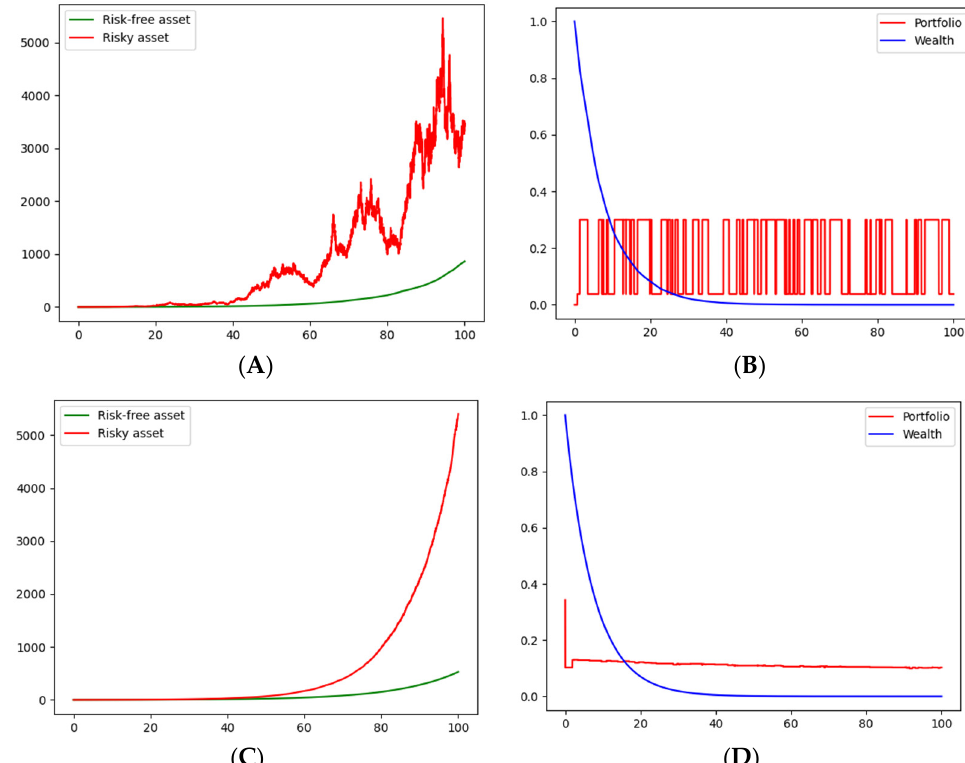
Figure 4. Second scenario, logarithmic utility, a 0 = r 0 = S 0 = X 0 = 1. Natural momentum ( µ 1 = 0.12, r 1 = 0.08, σ 1 = 0.2 ) vs. inferred momentum ( µ 2 = 0.06, r 2 = 0.055, σ 2 = 0.2 ) , with ρ = 0.12, γ = 1/3 and g = constant. ( A ) Price realization, ( B ) Portfolio strategy, ( C ) Average of price realizations, and ( D ) Average of portfolio strategies. Authors’ own elaboration.